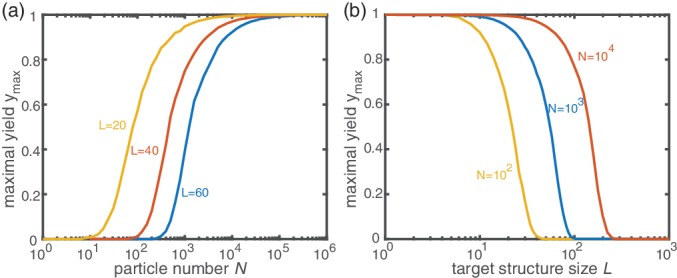
Dependence of the maximal yield y𝐦𝐚𝐱 in the activation scenario on N and L.For each data point, ymax was determined as the average yield of 100 independent stochastic simulations of the activation scenario with α=10-12. (a) Variation of the particle number N for different target sizes L. The maximal yield increases from 0 to 1 over roughly three order of magnitude in N. The onset of the transition depends on L. (b) Variation of the target size L for different particle numbers N. Increasing the target size L with N being fixed causes the maximal yield to drop to 0. The transition from 1 to 0 spans roughly one order of magnitude in L and its position is determined by N.